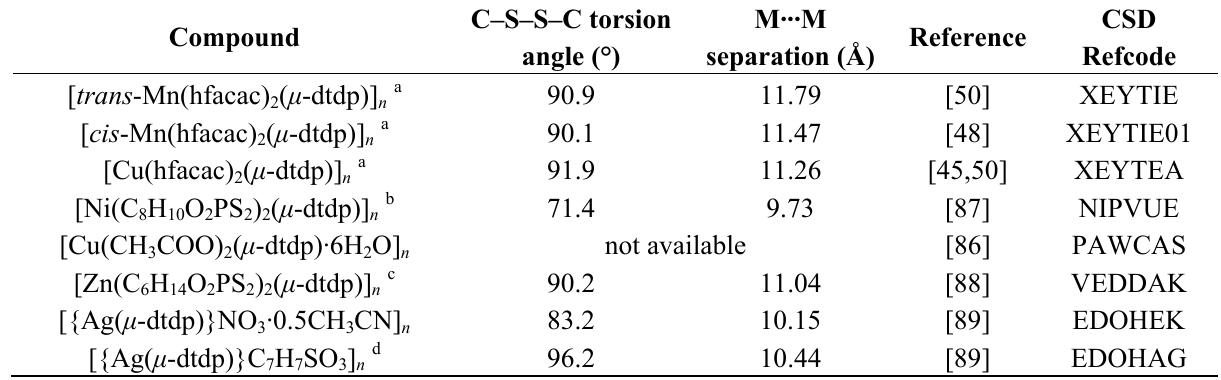
Table 4. Selected structural parameters for zigzag and helical